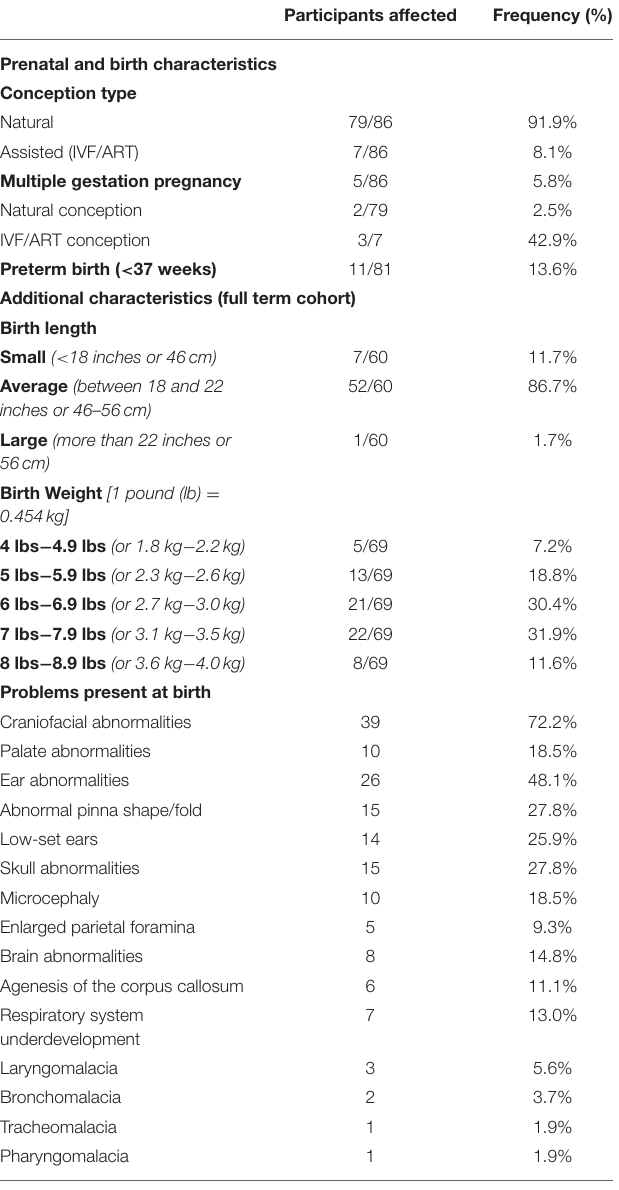
TABLE 7 | Prenatal and birth characteristics in the WAGR discovery cohort. TABLE 8 | Psychosocial and well-being characteristics in the WAGR discovery